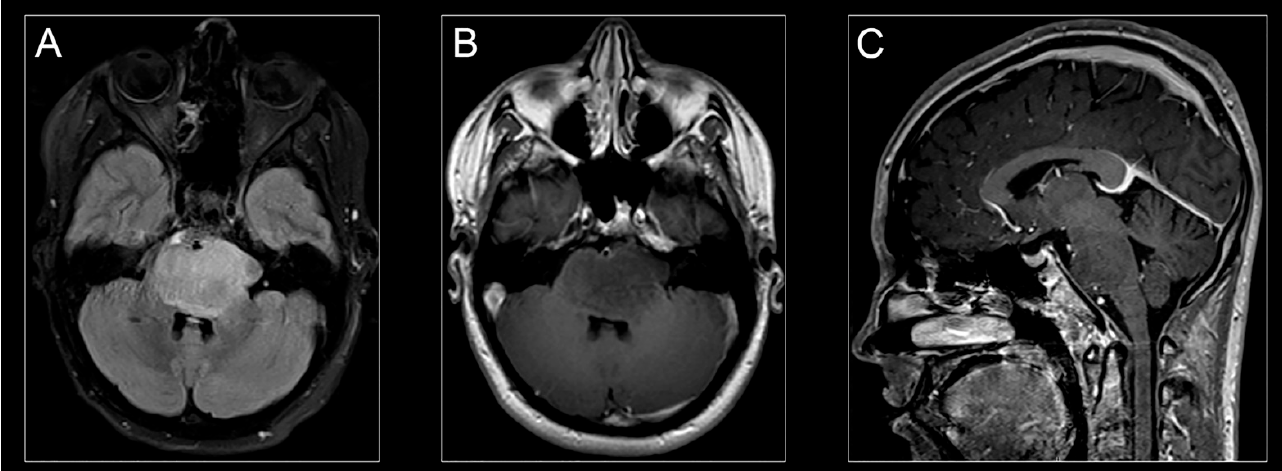
Figure 2. H3K27M-mutant diffuse midline glioma on MR imaging. Classic appearance of H3K27M-mutant diffuse midline glioma on MR-imaging: hyperintense signal on an axial T2-weighted fluid-attenuated inversion recovery (FLAIR) image ( A ), hypointense signal on an axial T1-weighted post-contrast image ( B ), and isointense signal on a sagittal T1-weighted post-contrast image ( C ). Table 1. Surgical biopsy for patients with H3K27M-mutant diffuse midline glioma. Recent clinical studies and trials utilizing surgical biopsy for patients with H3K27M-mutant diffuse midline glioma. Pathologic Diagnosis—Biopsied Tissue Technique and